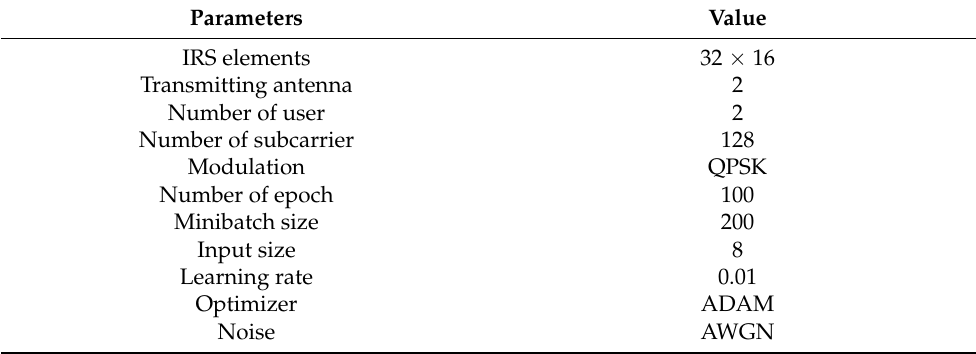
Table 1. Simulation